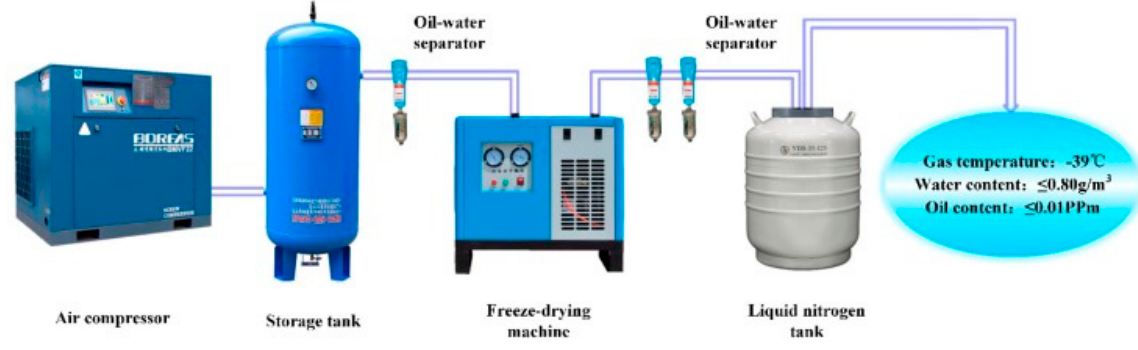
Figure 56. An exemplary illustration of a liquid nitrogen cooling system [170].